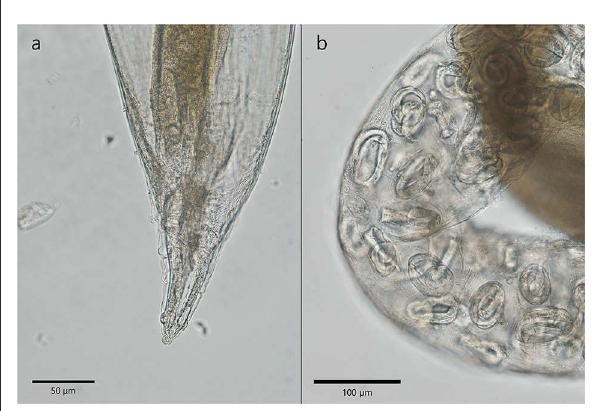
FIGURE4 The morphological characteristics of C. vulpis . (a) The posterior extremity of a female with stretched cuticular folds. Anal opening is visible; (b) Note the presence of eggs containing larva in the uterus of a female.